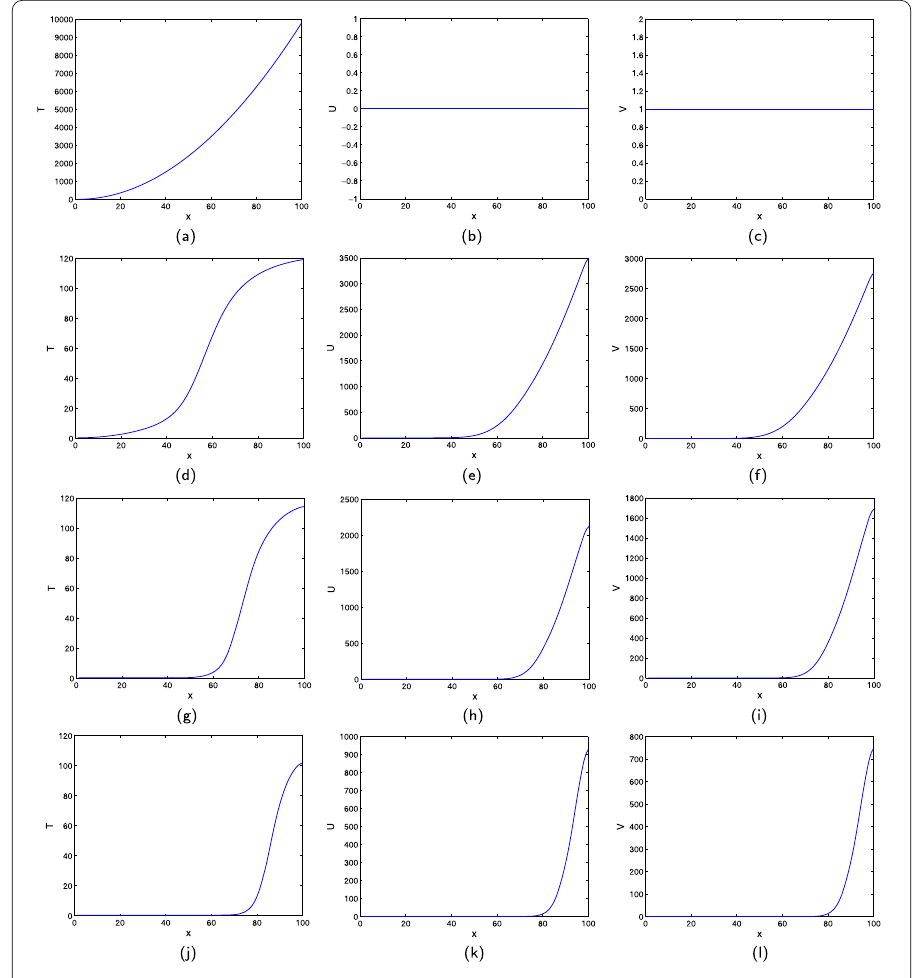
Figure 1 Snapshots of the approximate solutions T , U , and V of (1) for each row at the time t = 0, t = 1, t = 3, and t = 5. The parameters employed are λ = 0.1, β = 2, d = 5.05, κ = 0.03, δ = 0.016, γ = 3.0, c = 20.4, and N = 1000. We let φ T ( x ), φ U ( x ), and φ V ( x ) be as in Example 9. The approximations were calculated using our implementation of (76) in the Appendix, with τ = 0.00001 and h =